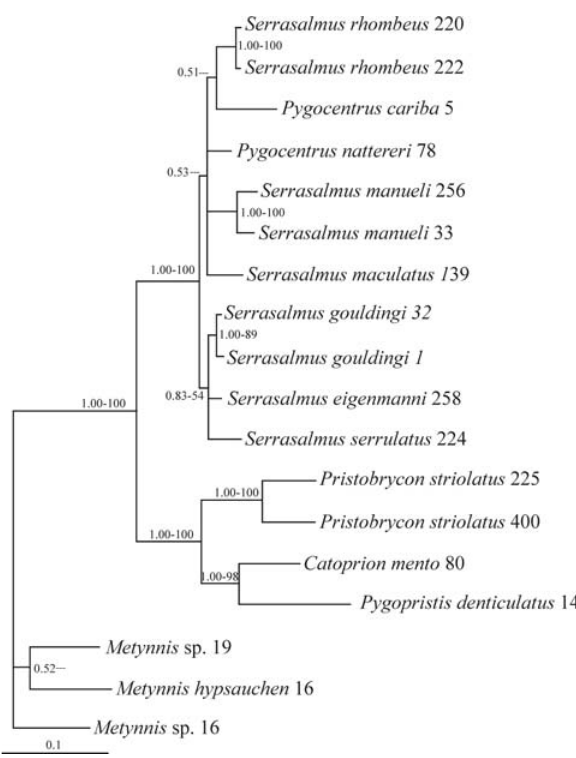
Figure 4 - Phylogeny of the piranha clade, obtained with Bayesian infer- ence based on control region mtDNA sequences (1216 total characters, 1130 bp and 86 indel characters). The combined data were partitioned into two categories, each with its independent model (Nst = 6 and rates = pinvar for DNA, and the standard model with rates = gamma for indel characters, see text for more details). Numbers next to nodes are posterior probabilities followed by a dash and bootstrap values (BV) from the maxi- mum parsimony